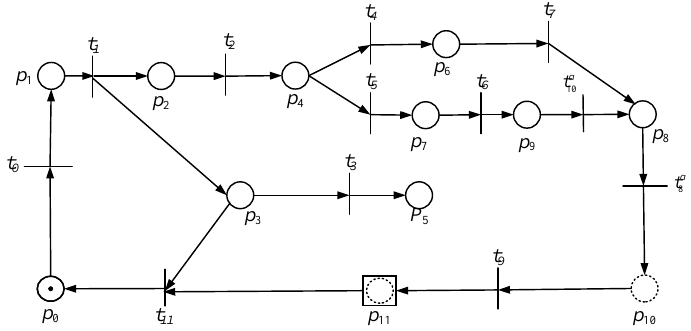
Figure 6. G M : the closed-loop system under